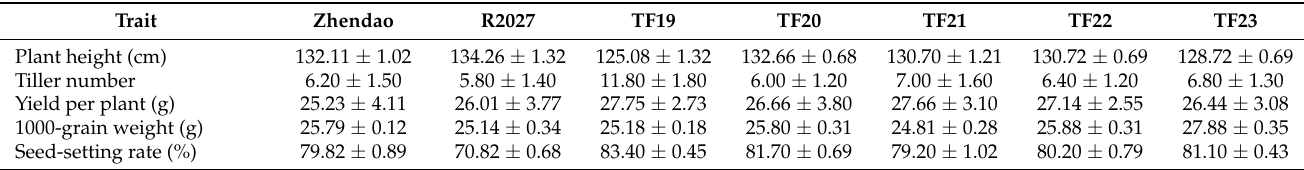
Table 3. Comparison of the main agronomic traits between five TF lineage plants and two parents (mean ± SD, n =